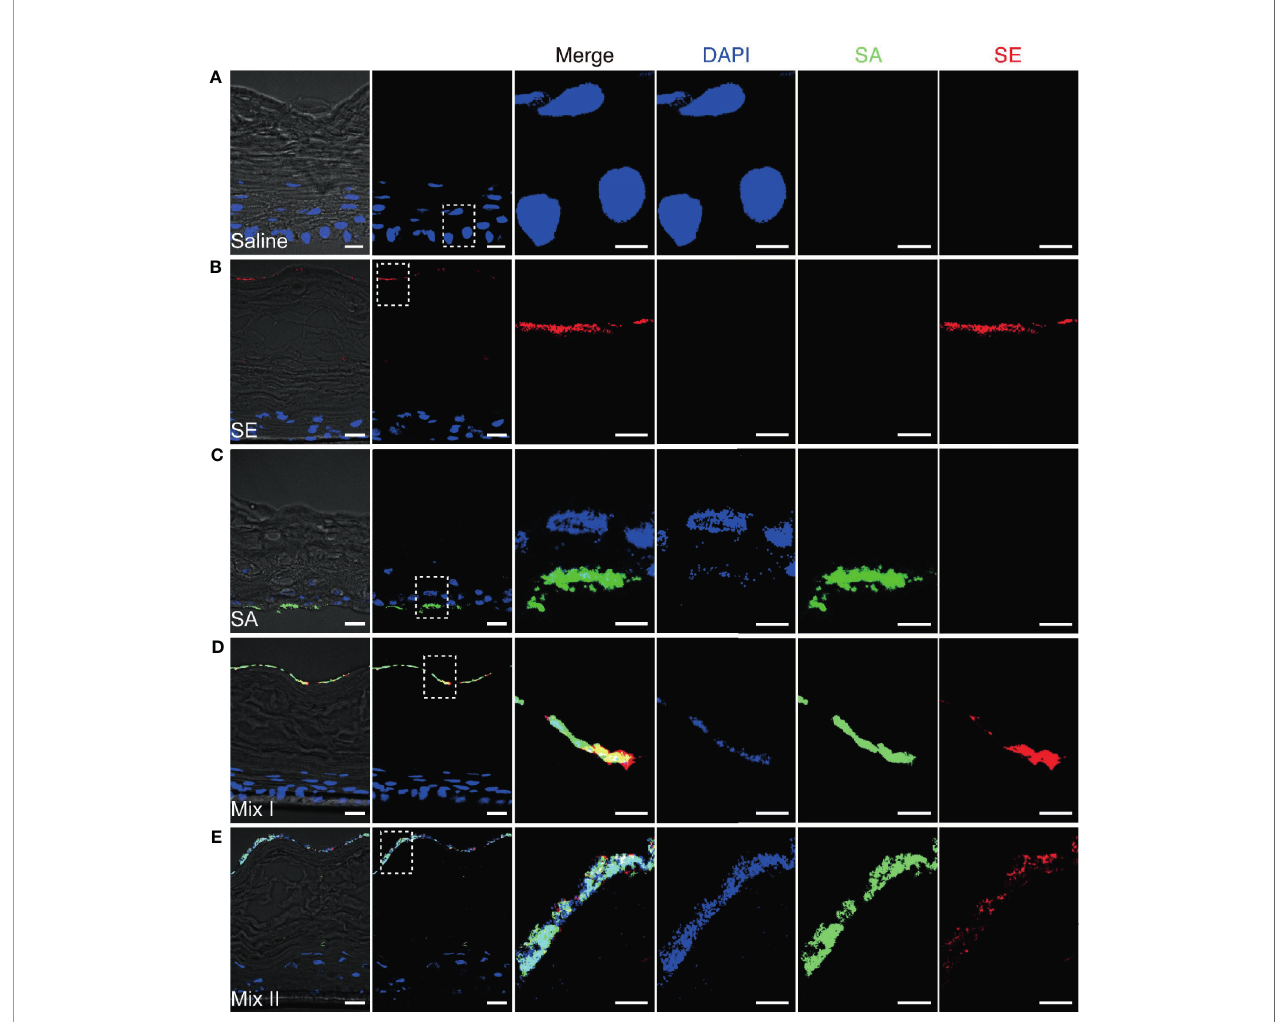
FIGURE 5 | Confocal fl uorescence microscopy illustrating the distribution and migration of the Staphylococci after 48h colonization. (A) The 3D human epidermal model exhibits differentiated, strati fi ed layers; (B) S. epidermidis remained on the surface of the 3D epidermal model; (C) S. aureus penetrated through the epidermal layers and invaded the bottom layer of the epidermal tissue; (D, E) The presence of S. epidermidis prevented S. aureus from invading the deeper epidermis. SA, S. aureus was inoculated at an infective dose of 10 3 CFU/well; Mix I, S. epidermidis and S. aureus were inoculated simultaneously at infective dose of 10 3 and 10 5 CFU/well, respectively; Mix II, S. epidermidis was inoculated at an infective dose of 10 5 CFU/well and 4h prior to 10 5 CFU/well of S. aureus. Bar: 20 m m for the original view and 10 m m for the enlarged